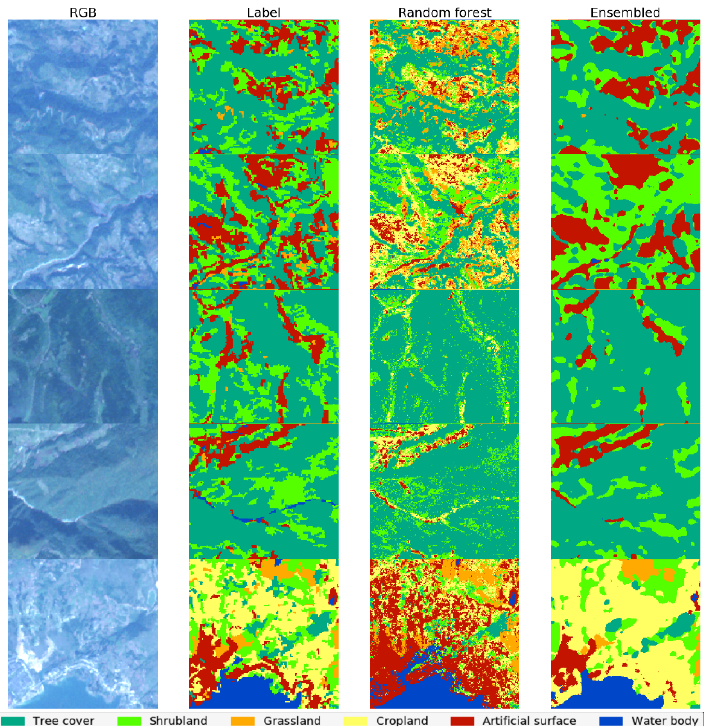
Figure 15. A comparison of random forest and the ensemble average of SegNet, U-Net, and PSPNet on land cover classification. The first column shows the RGB image, the second column shows the ground truth label, the third column shows the classification results from random forest, and the fourth column shows the classification results from the ensemble average of SegNet, U-Net, and PSPNet